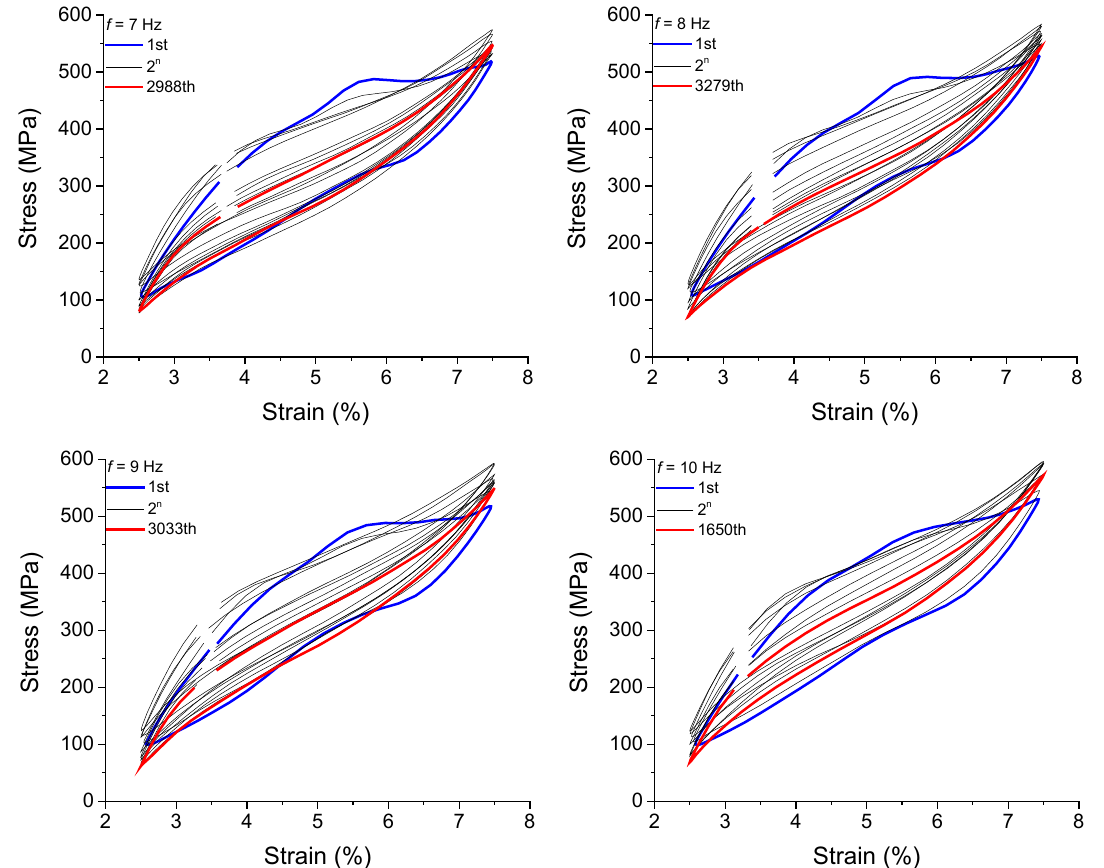
Figure 18. Stress vs. strain superelastic response of the reference element for loading frequencies from 7 Hz to 10 Hz.